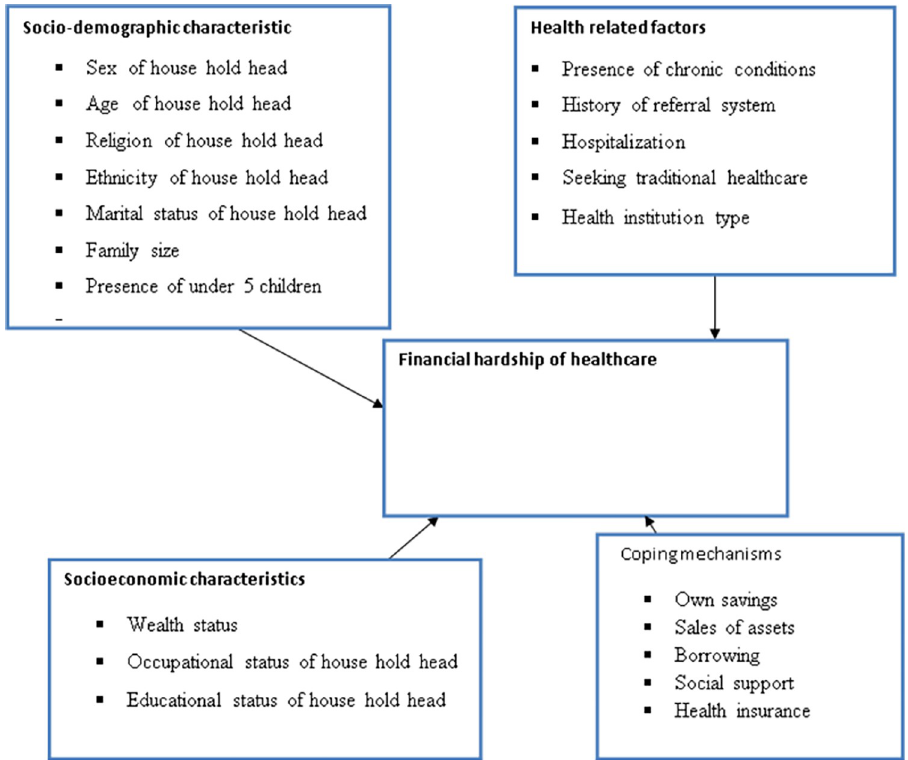
Fig 1. Conceptual framework depicts relationships between financial hardship of health care and predictor